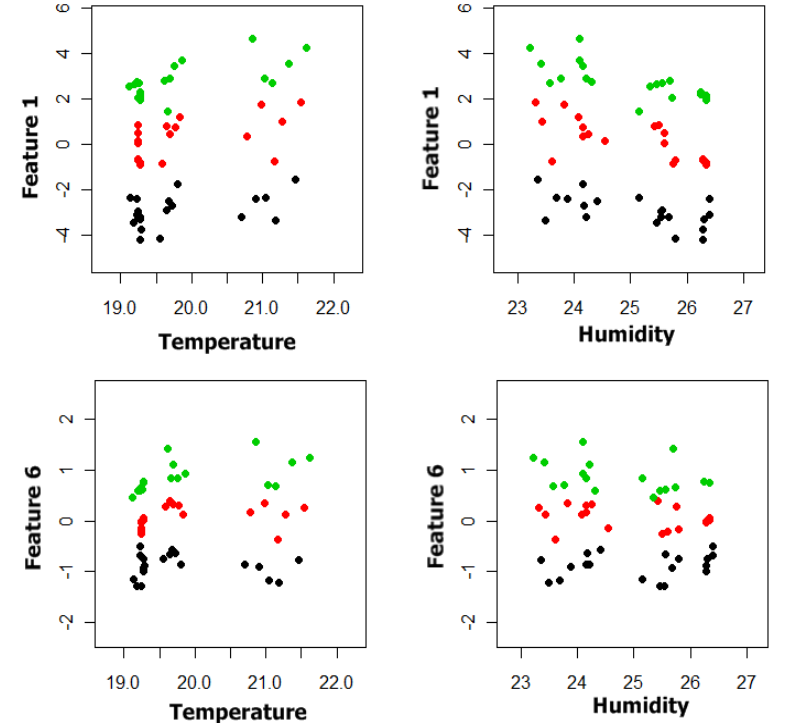
Figure 9. Features 1 and 6 versus temperature and humidity.